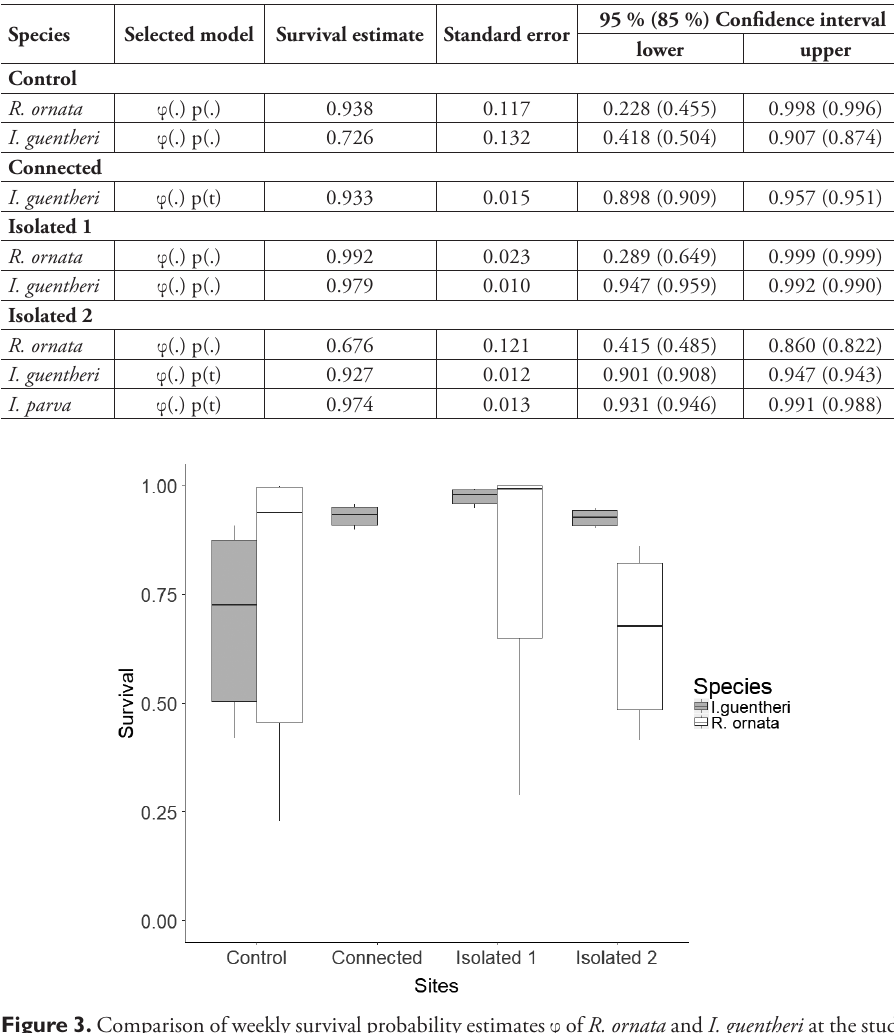
Figure 3. Comparison of weekly survival probability estimates φ of R. ornata and I. guentheri at the study sites. Data of R. ornata in the “connected” site were not sufficient for estimation. The survival estimate, upper and lower 85% confidence intervals (boxes) and the upper and lower 95% confidence intervals are indicated (minimum and maximum